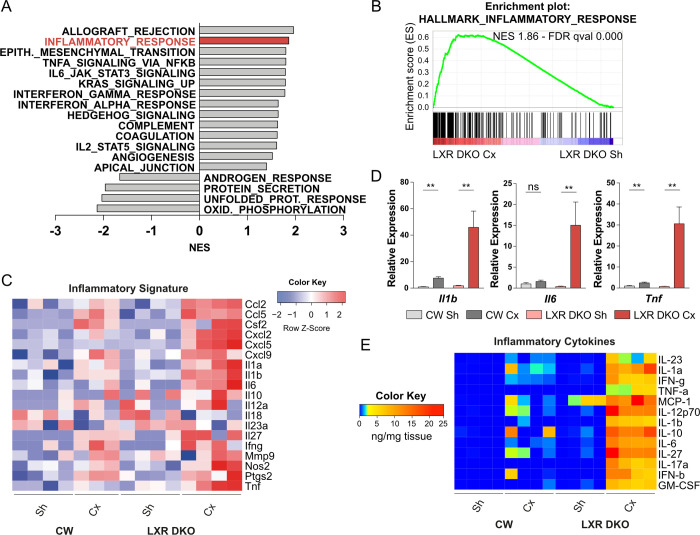
Androgen deprivation promotes chronic inflammation in LXR-null prostates.(A and B) Hallmark gene sets enrichment scores (A) and enrichment plot of inflammatory gene set (B) by GSEA analysis of RNA sequencing showing an inflammatory response following 1-month castration in LXR DKO. (C) RNA sequencing analysis of pro-inflammatory genes expression (log2FC) confirms a pro-inflammatory environment in 1-month Cx LXR DKO mice. (D) Inflammatory Il1b, Il6, and Tnf gene expression analysis by RT-qPCR. (E) Quantification of intraprostatic inflammatory cytokines by multiplex beads-based immunoassay. Data are expressed in nanograms per micrograms of tissue. Groups are composed of at least 4 animals. Bars represent mean ± SEM. Statistical analyses were performed via Mann–Whitney test. *p < 0.05, **p < 0.01, ***p < 0.001 and ns. For numerical raw data, please see S1 Data. For supporting dataset, please see S2–S6 Datas. CW, control wild-type; Cx, castrated; LXR, liver X receptor; GSEA, Gene Set Enrichment Analyses; LXR DKO, LXR alpha and beta double knock-out; NES, Normalized Enrichment Score; ns, nonsignificant; RT-qPCR, quantitative reverse transcription PCR; Sh, sham-operated.